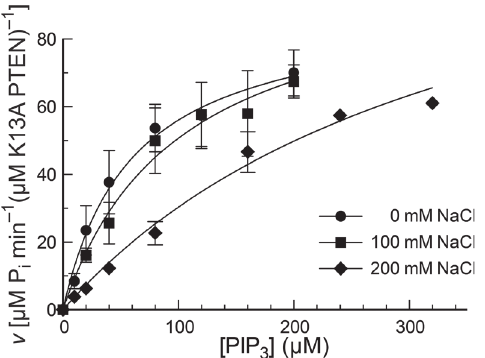
Figure 5. Turnover of PIP 3 by K13A PTEN in solutions of various salt concentrations. Reactions were performed in 50 mM Tris – HCl buffer, pH 7.6, containing NaCl (0, 100, or 200 mM), EDTA (2.0 mM), MESG (0.20 mM), and DTBA (40 mM), and were initiated with the addition of K13A PTEN to 20 nM. Values are for maximum reaction velocity ( ± SE) at < 10% turnover of substrate in reactions performed in triplicate or more. The resulting kinetic parameters are listed in Table